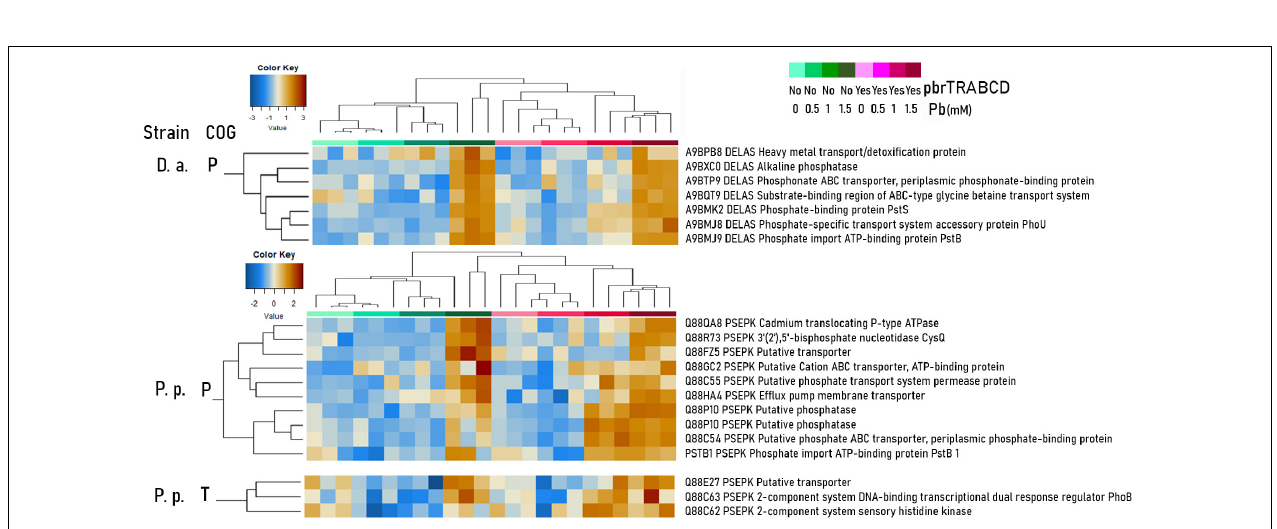
FIGURE 6 | Centered-scaled log-2-transformed abundances of Pseudomonas putida KT2440 (P.p.) and Delftia acidovorans SPH-1 (D.a.) proteins (two or more identified peptides) of interest belonging to P (inorganic ion transport and metabolism) and T (signal transduction mechanisms) COGs are displayed in heat maps (Euclidean distance, average clustering; entire heat maps: see “Heat Map Supplementary Material